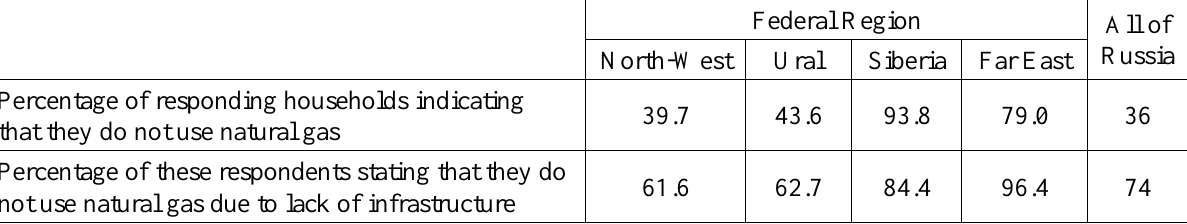
Table 1. Results from a questionnaire survey about the lack of natural gas in Russian Federal Regions (RUSSTAT